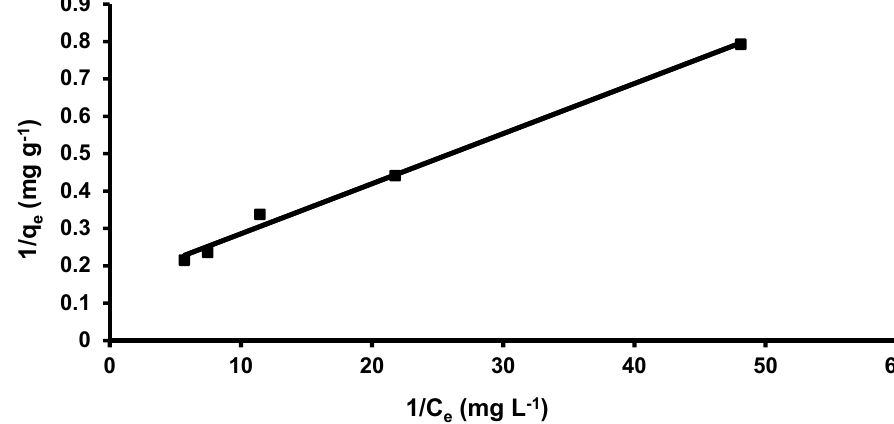
Figure 12. Linear Langmuir isotherm for the sorption of IV2R.